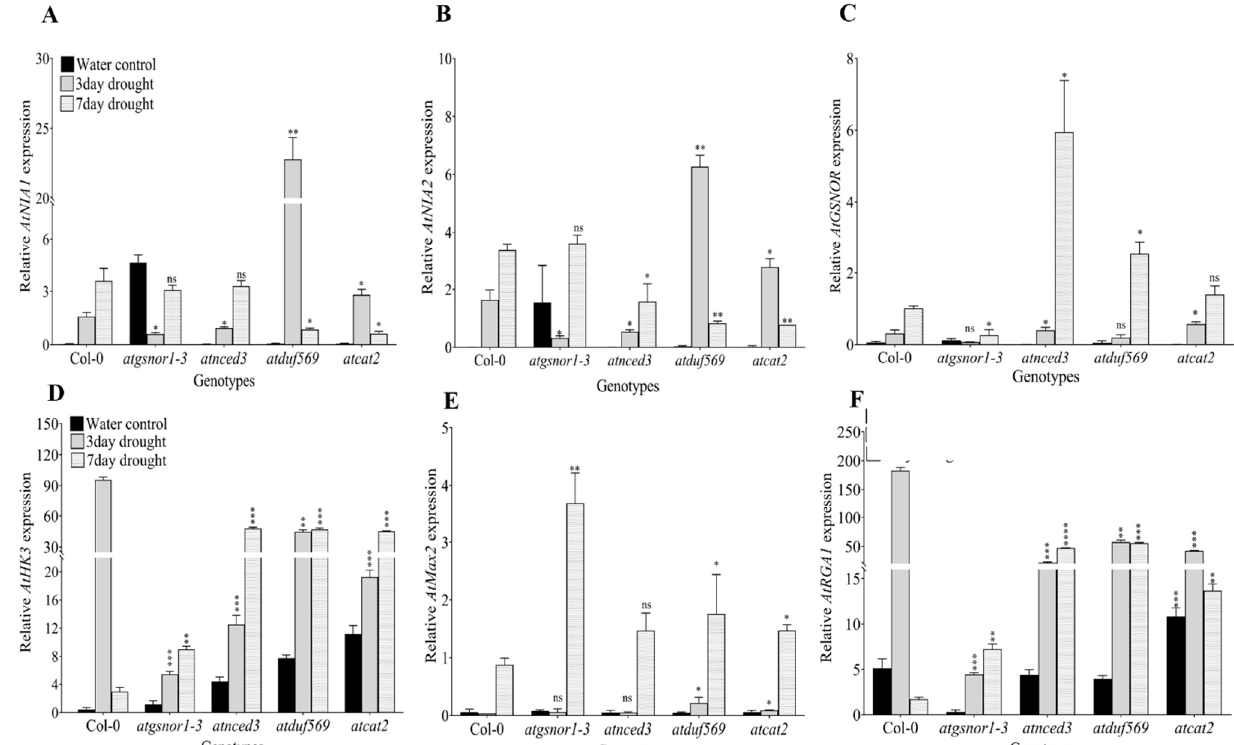
Figure 5. Expression analysis of genes involved in nitrate reductase, abscisic acid signaling, strigolactone signaling, cellular redox, and iron tolerance in the given Arabidopsis lines under drought stress. The gene expression levels of ( A ) AtNIA1 , ( B ) AtNIA2 , ( C ) AtGSNOR , ( D ) AtHK3 , ( E ) AtMAX2 , and ( F ) AtRGA1 in various Arabidopsis genotypes. Data represent the means of values obtained from experiments performed in triplicate. Error bars represent standard deviation. Means were analyzed for significant differences using Student’s t -test. Asterisks (*) indicate significant whereas “ns” indicate non-significant differences at 5% level of significance (**** p < 0.001, *** p < 0.001, ** p < 0.01, * p < 0.05).